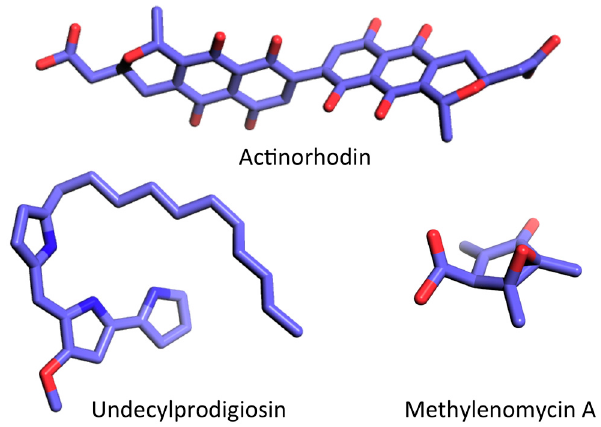
Figure 2. Examples of secondary metabolites produced by S. coelicolor . Structures were obtained from the PubChem database and rendered using PyMol (C, light blue; N, dark blue; O, red). Actinorhodin, CID 441143; undecylprodigiosin, CID 135515151; methylenomycin A, CID 122733.